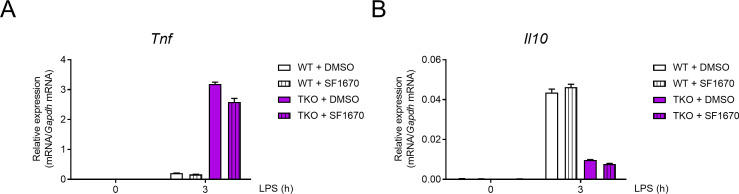
The regulation of TNF and IL-10 by miR-17~92 family miRNAs is independent of PTEN.(A and B) qPCR analysis of Tnf (A) and Il10 (B) mRNA in WT and TKO BMDMs stimulated with or without LPS for 3 hr in the presence or absence of a PTEN inhibitor SF1670 (2 μM). Data are representative of three independent experiments (mean + s.d.).